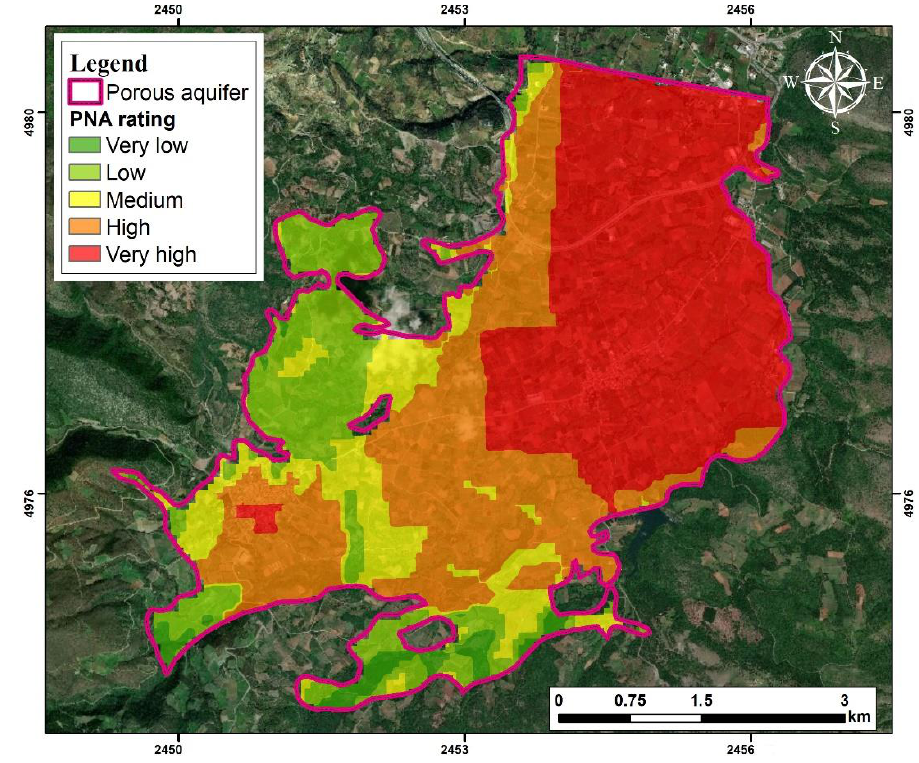
Figure 6. Final vulnerable nitrate zone assessment with PNA.